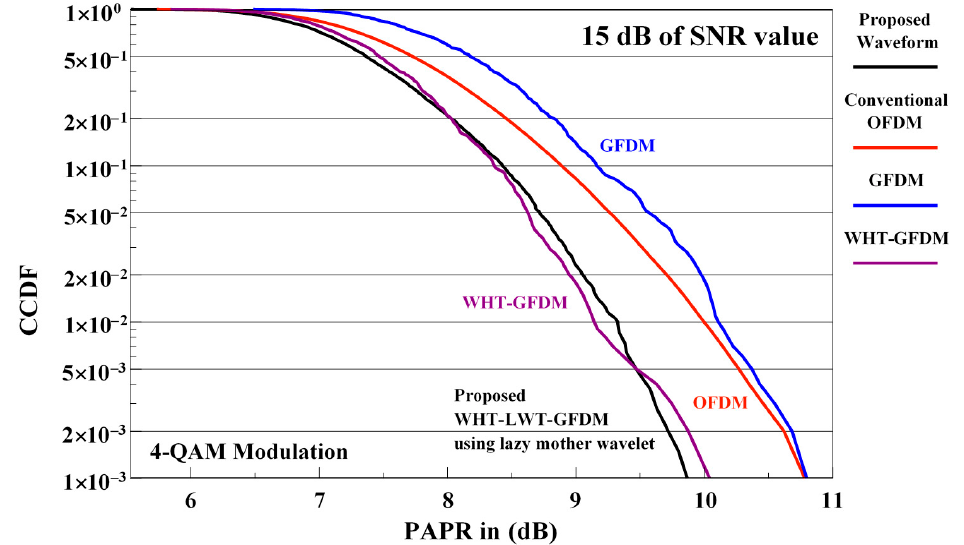
Figure 12. The PAPR performance comparisons of conventional OFDM, GFDM, WHT-GFDM, and WHT-LWT-GFDM waveforms in case of 4-QAM modulation for a SNR of 15 dB at receiver side.